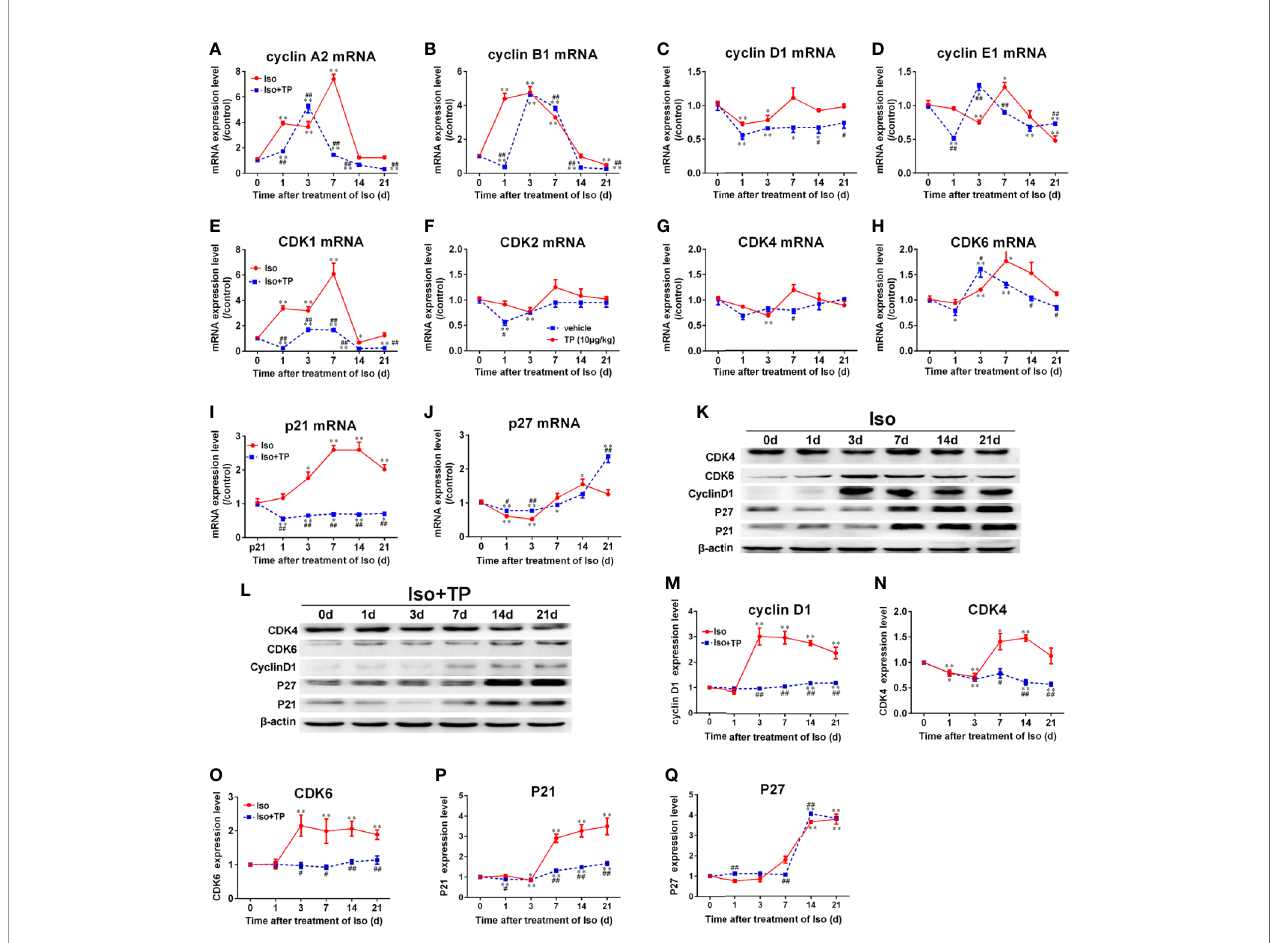
FIGURE 6 | The effects of TP on the myocardial expression of cell cycle regulators in mice. (A – J) The mRNA expression levels of all cell cycle regulators. (K, L) cyclin D1, CDK4 and 6, P21, and P27 protein levels as shown by Western blot analysis ( n = 4 per group). (M – Q) The intensity of each band was quanti fi ed by densitometry and normalized to b -actin and control group. The data are shown as the mean ± SEM ( n = 5), *P < 0.05, **P < 0.01 compared with the controls (0 day); # P < 0.05, ## P < 0.01 compared with the Iso-treated group at the same time point (one-way